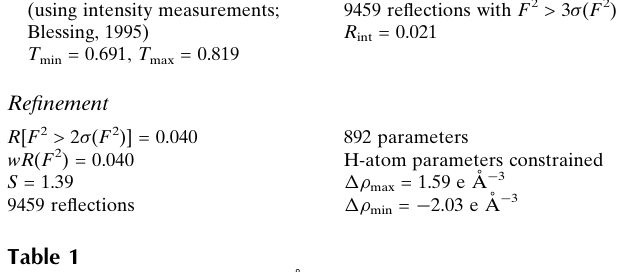
Selected geometric parameters (A˚ , (cid:3)